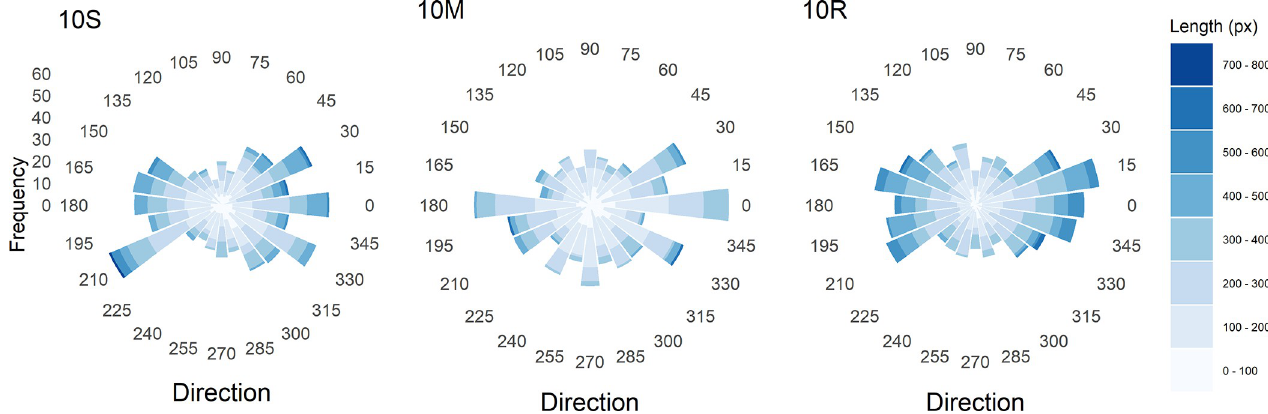
Fig 11. Histograms of direction (in polar coordinates) and length of the paths between successive dots for the two conditions (10S, 10M) in Experiment 3, and for the random-dot pattern (10R).